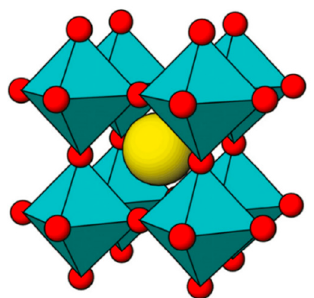
Figure 1. Crystal structure of perovskite: A-cation (yellow), B-cation (blue octahedra), X-anion (red). Reprinted with permission from Ref [43]. Copyright (2020) ACS publications.